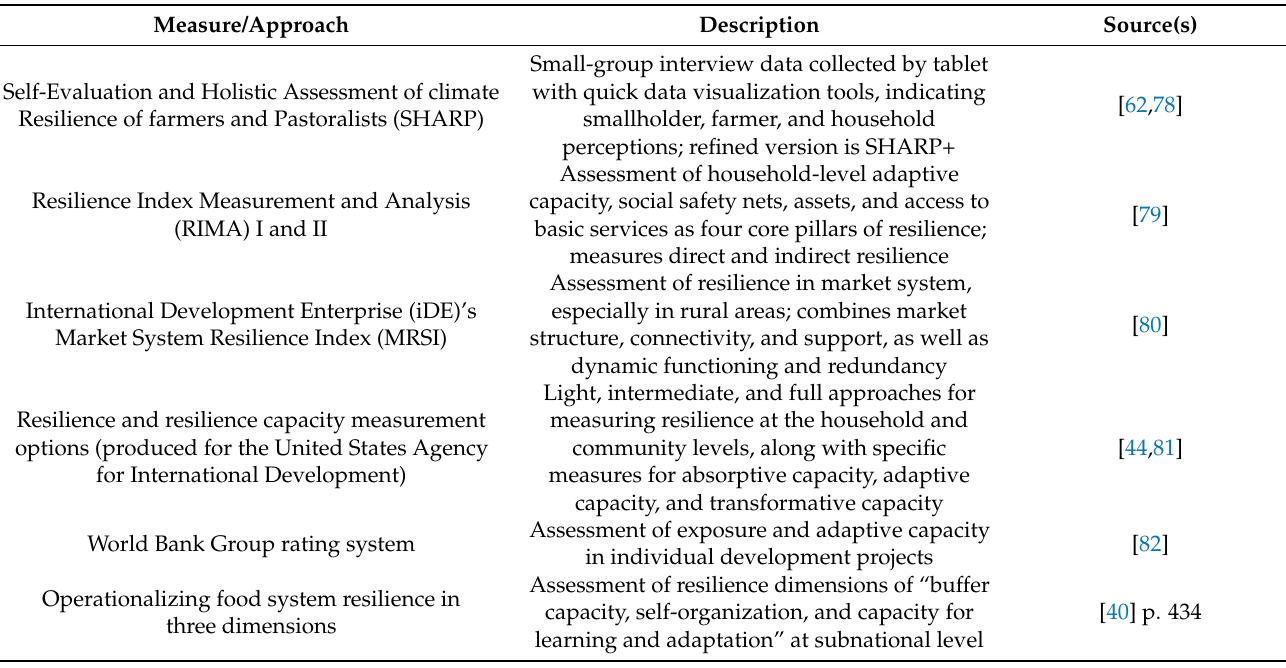
Table 3. Subnational resilience